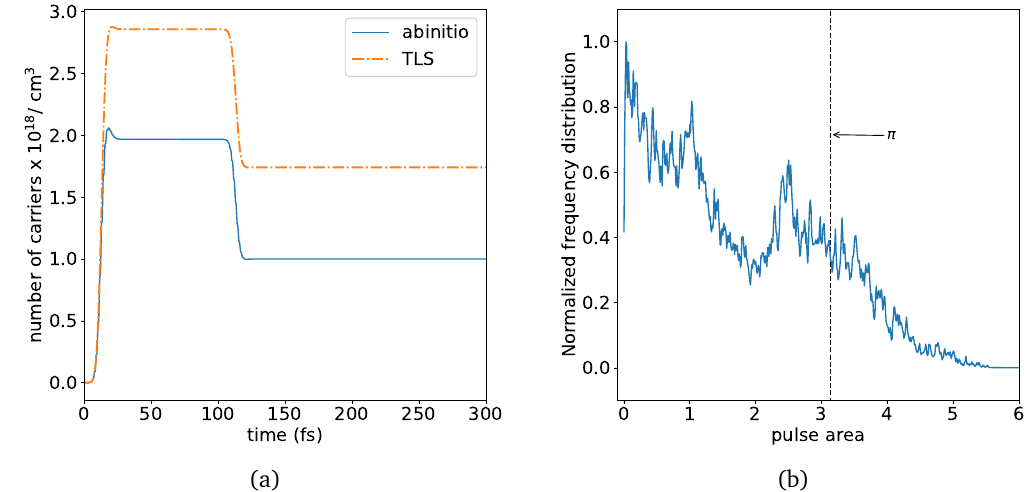
Figure 4: (a) Time dynamics of the carriers in the high-field regime. ab initio results (blue continuous line) are compared with TLS simulations (orange dashed line). The two curves evidence the same behavior, whereas the TLS model overestimates the number of the carriers. (b) Normalized frequency distribution of the values of the pulse area for all the transitions activated by the laser pulse. The vertical dashed line indicates the area of the π